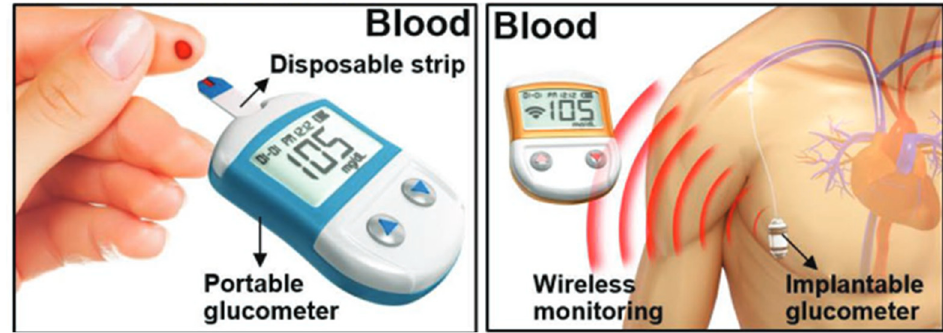
Figure 8. Invasive glucose monitoring systems [109].